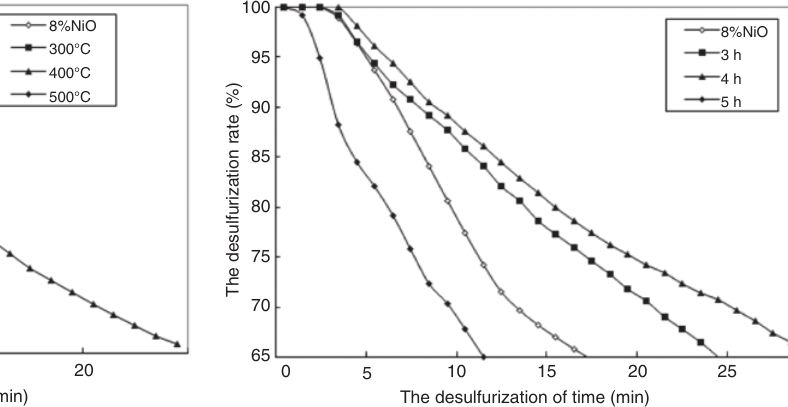
Figure 3: Effect of different calcination temperature on the catalyst desulfurization performance.